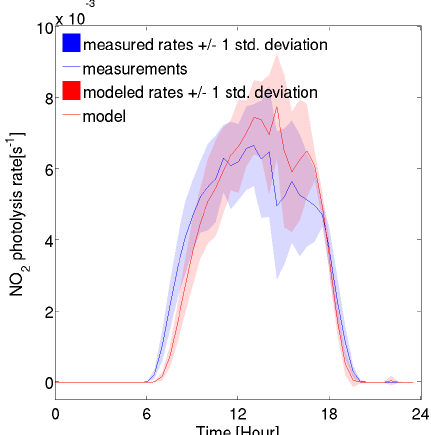
Figure 7. Averaged modeled and measured diurnal cycles of pho- tolysis rate NO 2 . Measurement average (line) and ± 1 standard de- viations (shaded area) are in blue; model average (line) and ± 1 standard deviations (shaded area) are in red. The comparison for photolysis rate is made above the canopy at